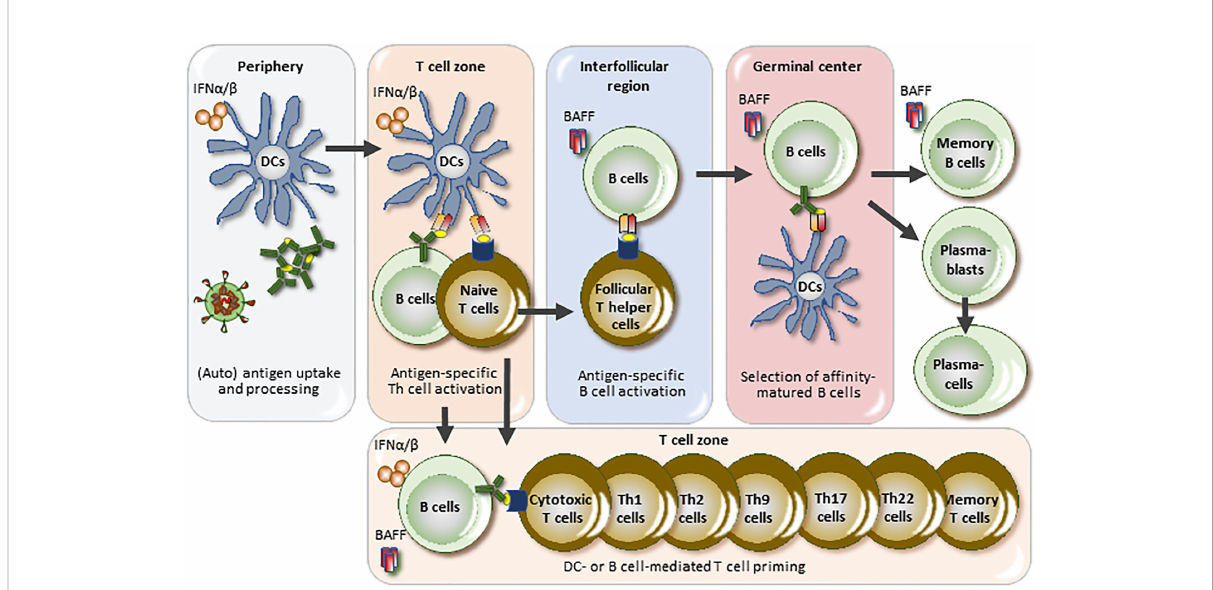
FIGURE 2 BAFF and IFNAR1 in the pathogenesis and disease activity of SLE. Lupus autoantigens stimulate antigen-presenting cells to secrete interferon- alpha and -beta (IFN a / b ) just like viral particles, a process that triggers an antiviral-like adaptive immune response against lupus autoantigens. Lupus activity largely depends on the size and activity of the autoreactive T and B cell clones and IFNAR1 signaling is centrally involved in clone size regulation triggered by extracellular lupus autoantigens but not necessarily by drug- or bacterial infection-related lupus fl ares. B cell-activating factor (BAFF) is speci fi cally involved in B cell maturation towards plasma cells but may also endorse B cell-mediated T cell priming. DC, dendritic